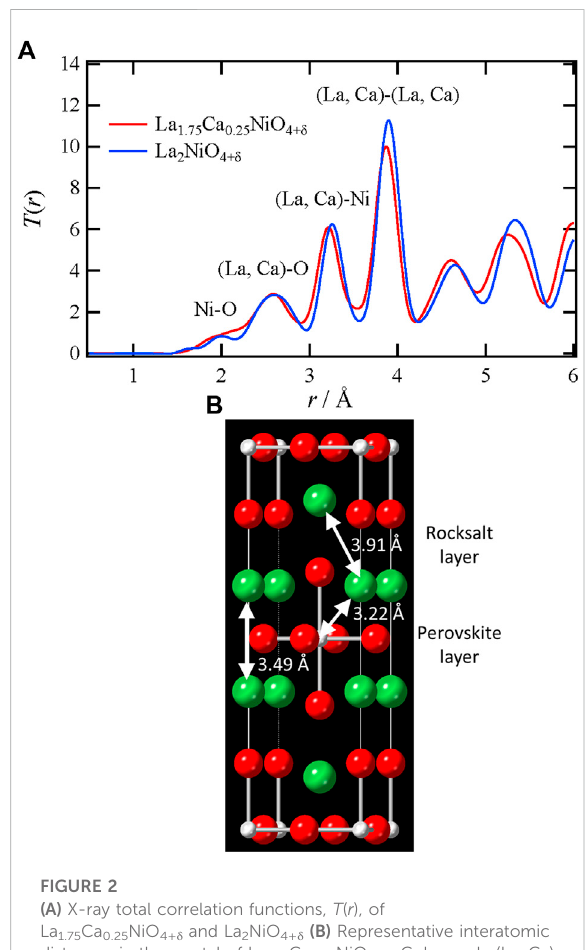
FIGURE 2 (A) X-ray total correlation functions, T ( r ), of La 1.75 Ca 0.25 NiO 4+ δ and La 2 NiO 4+ δ (B) Representative interatomic distances in the crystal of La 1.75 Ca 0.25 NiO 4+ δ . Color code (La, Ca) site, green; Ni site, gray; O site,